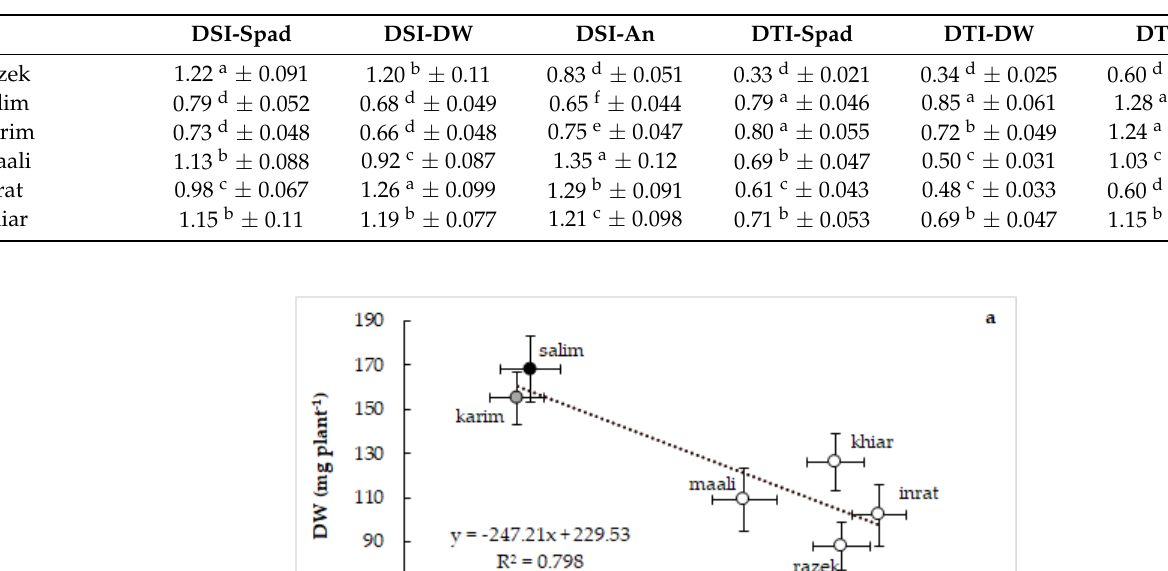
Table 3. Drought susceptible index (DSI) was calculated based on the Spad index (DSI-Spad), biomass production (DSI-DW), and net photosynthesis (DSI-An), and the drought tolerance index was calcu- lated based on the Spad index (DTI-Spad), biomass production (DTI-DW), and net photosynthesis (DTI-An) in six Tunisian genotypes of durum wheat ( Triticum durum Desf.) subjected to drought stress. According to Fisher’s least significant difference, within columns, means with the same letter are not significantly different at α = 0.05. Standard errors of means of 10 replicates.